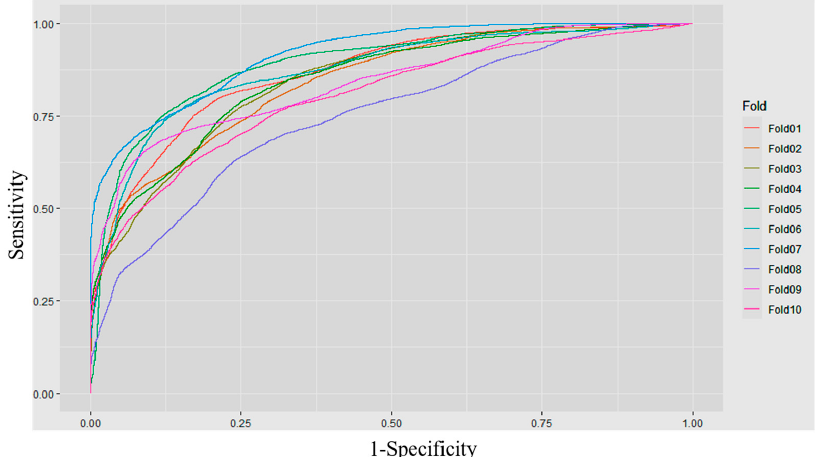
Figure 2. ROC curves of ten-fold cross-validation based on XGBoost.